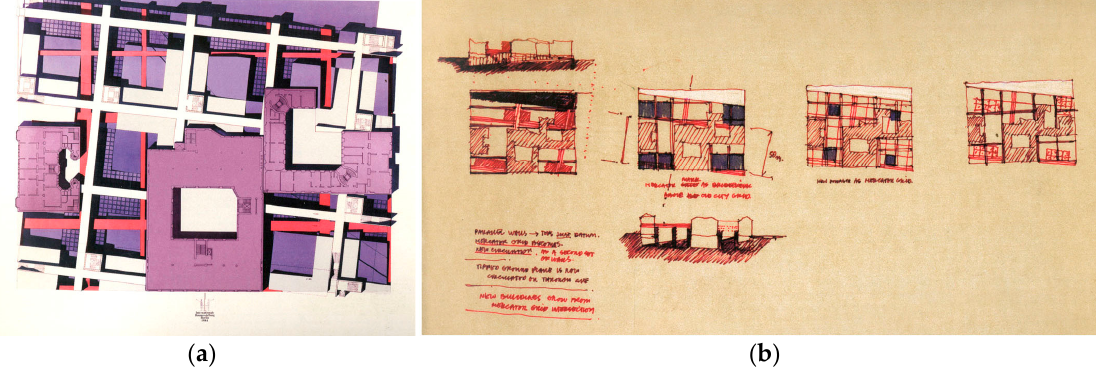
Figure 9. Peter Eisenman, plates for IBA 84. ( a ) Plan view of Block 5; ( b ) Sketches,